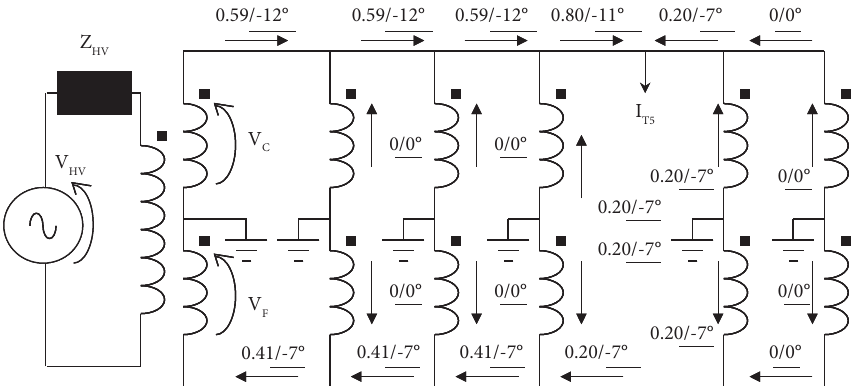
Figure 7: Currents for the example with only one train, with Z